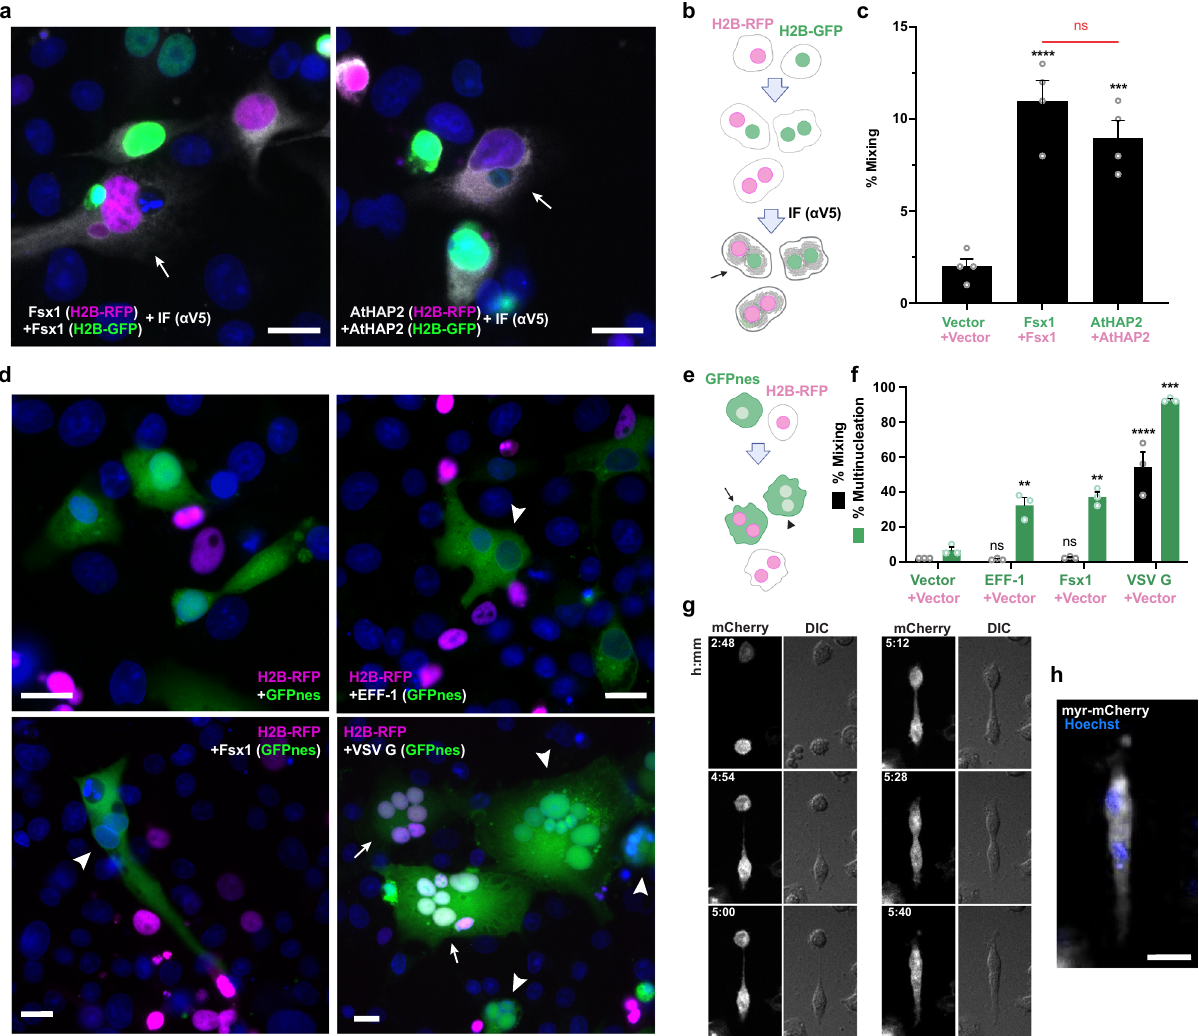
Fig. 4 Fsx1 mediates bilateral cell – cell fusion. a – c Cell – cell fusion was measured by content-mixing, indicated by the appearance of multinucleated cells containing green nuclei (H2B-GFP) and magenta nuclei (H2B-RFP). Immuno fl uorescence against the V5 tag was also performed (gray). a Images of mixed cells. DAPI, blue. Scale bars, 20 µ m. See also Supplementary Fig. 7a. b Scheme of experimental design. c Quanti fi cation of content-mixing. The mixing indices presented as means± SEM of four independent experiments. Comparisons by one-way ANOVA followed by Bonferroni ’ s test. ns = non-signi fi cant, *** p < 0.001, **** p < 0.0001. Source data are provided as a Source Data fi le. d – f Unilateral fusion was evaluated by mixing control cells expressing nuclear H2B-RFP (magenta) with cells expressing GFP with a nuclear export signal (GFPnes, green cytoplasm) only or together with Fsx1, EFF-1 or VSV G. d Images of cells transfected with empty::GFPnes vector, Fsx1::GFPnes, EFF-1::GFPnes or VSV G::GFPnes. Fsx1 and EFF-1 show multinucleated GFPnes positive cells (arrowheads). VSV G multinucleated cells are found with GFP only (arrowheads) or with both markers (arrows). Scale bars, 20 µ m. See also Supplementary Fig. 7e. e Scheme of experimental design. f Quanti fi cation of content-mixing experiments in which only the GFP population of cells express Fsx1, EFF-1, VSV G, or none of them (vector). Bar chart showing means ± SEM of three independent experiments. Comparisons by one-way ANOVA followed by Dunett ’ s test against the vector. ns = non-signi fi cant, ** p < 0.01, *** p < 0.001, **** p < 0.0001. Source data are provided as a Source Data fi le. g Spinning disk microscopy time-lapse images indicating the merging of two cells expressing myr-mCherry and Fsx1. Time in hours:minutes. The red channel (mCherry, white) and the DIC are shown. Refer to Supplementary Movie 1. h For the last point a Z-projection showing the myr-mCherry fl uorescence (white) and the nuclei Hoechst (blue; Supplementary Movie 2). Scale bar, 20 µ